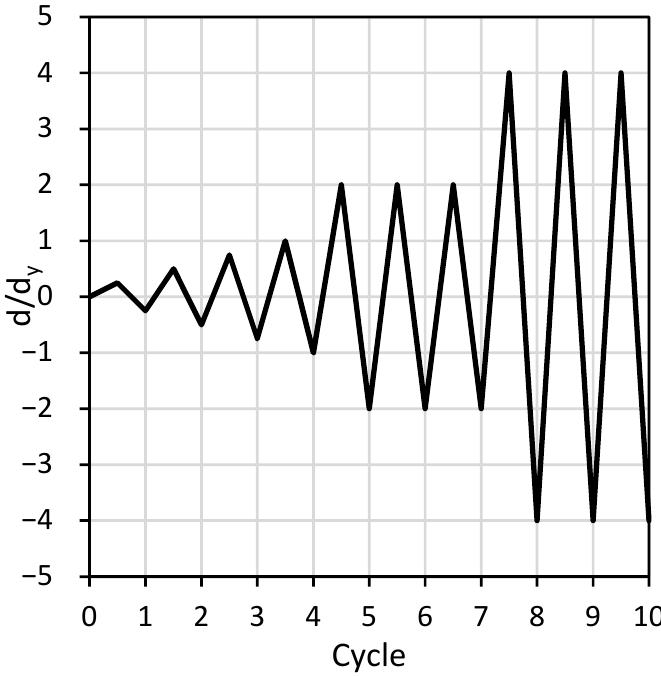
Figure 2. Cyclic loading protocol according to the ECCS [33].